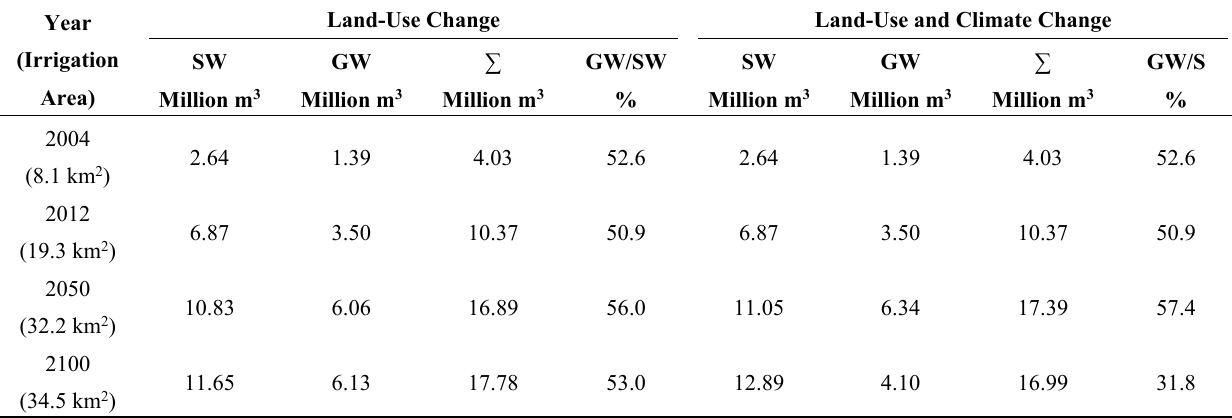
Table 3. Distribution of the water resources for irrigation in the past, present, and future. Land-Use Change Land-Use and Climate Change Year SW Area) Million m 3